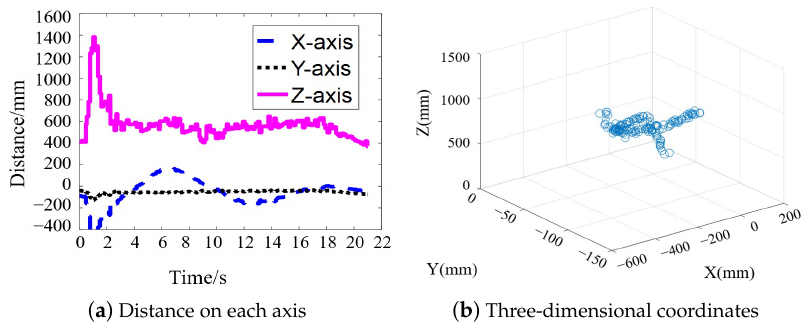
Figure 17. The course angle measured by the vision of the follower robot and the leader robot compared with the self course angle measured by the MENS sensor over time.